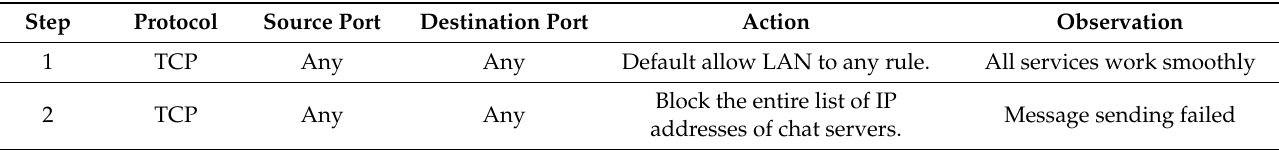
Table 6. Firewall rules for blocking the chat servers.